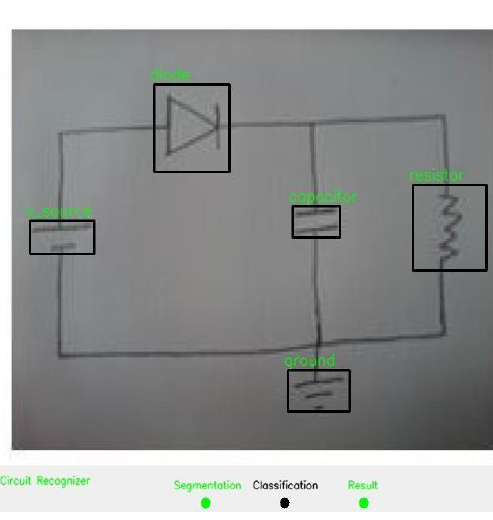
Fig. 2: Classification of components